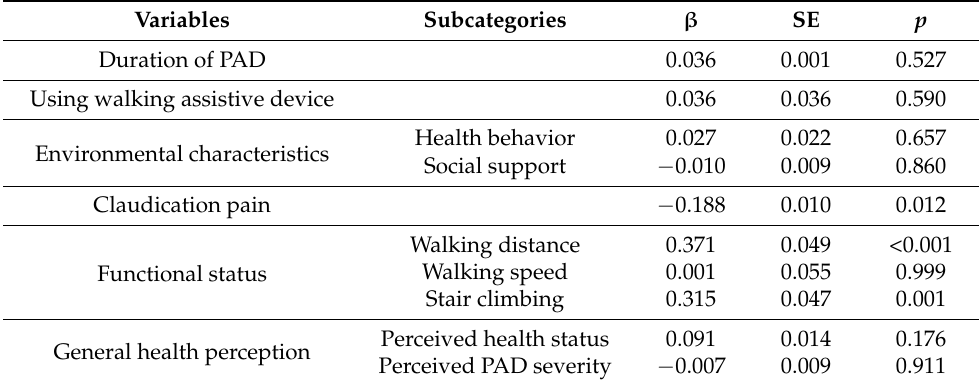
Table 4. Multiple linear regression analysis in relation to HRQOL ( n =